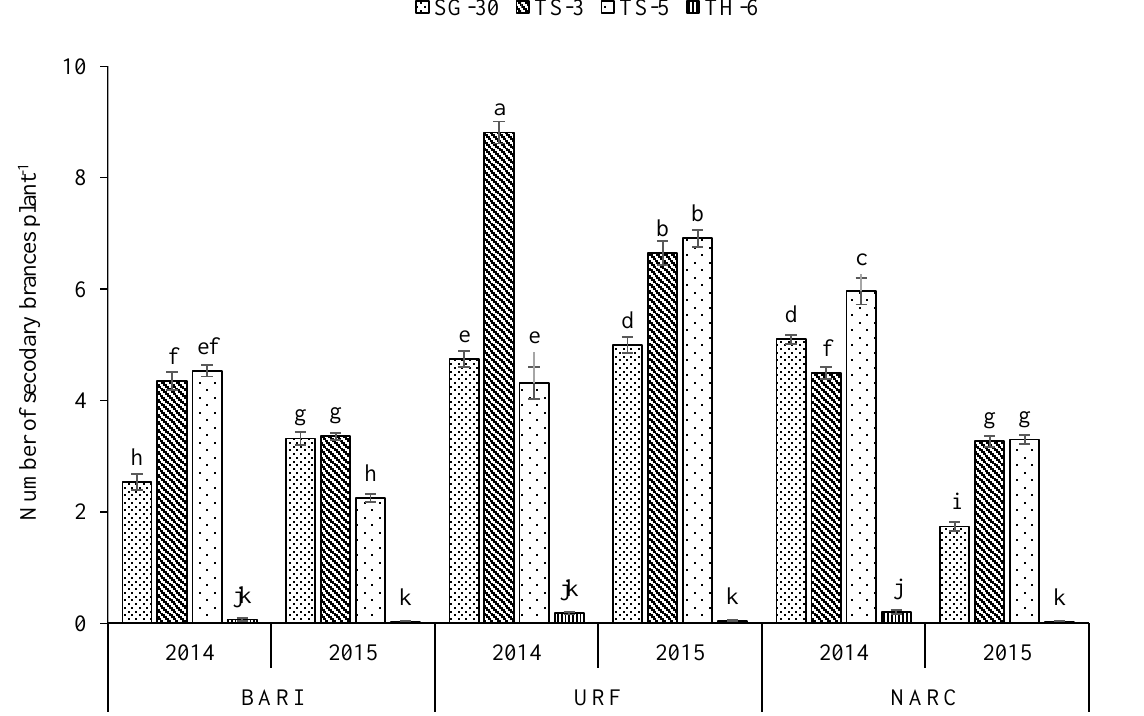
Figure 4. Number of secondary branches plant −1 of four sesame cultivars at three locations during 2014 and 2015 (pooled over micronutrients). The bars indicates standard error (±SE) of mean (n = 3). All means are significantly different at p ≤ 0.05.